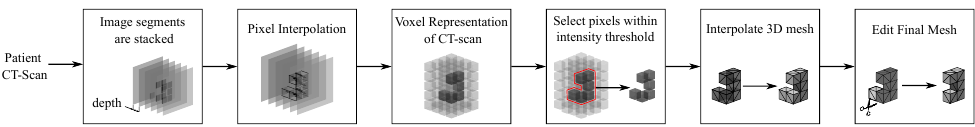
Figure 3. Workflow process of converting CT scan data to 3D models to be displayed as virtual ele- ments within the simulator. Image segments are layered so pixels can be interpolated between images. The pixels are interpolated into voxels (3D pixels), which can then be used to create approximate 3D meshes. The meshes are then completed through a final manual editing